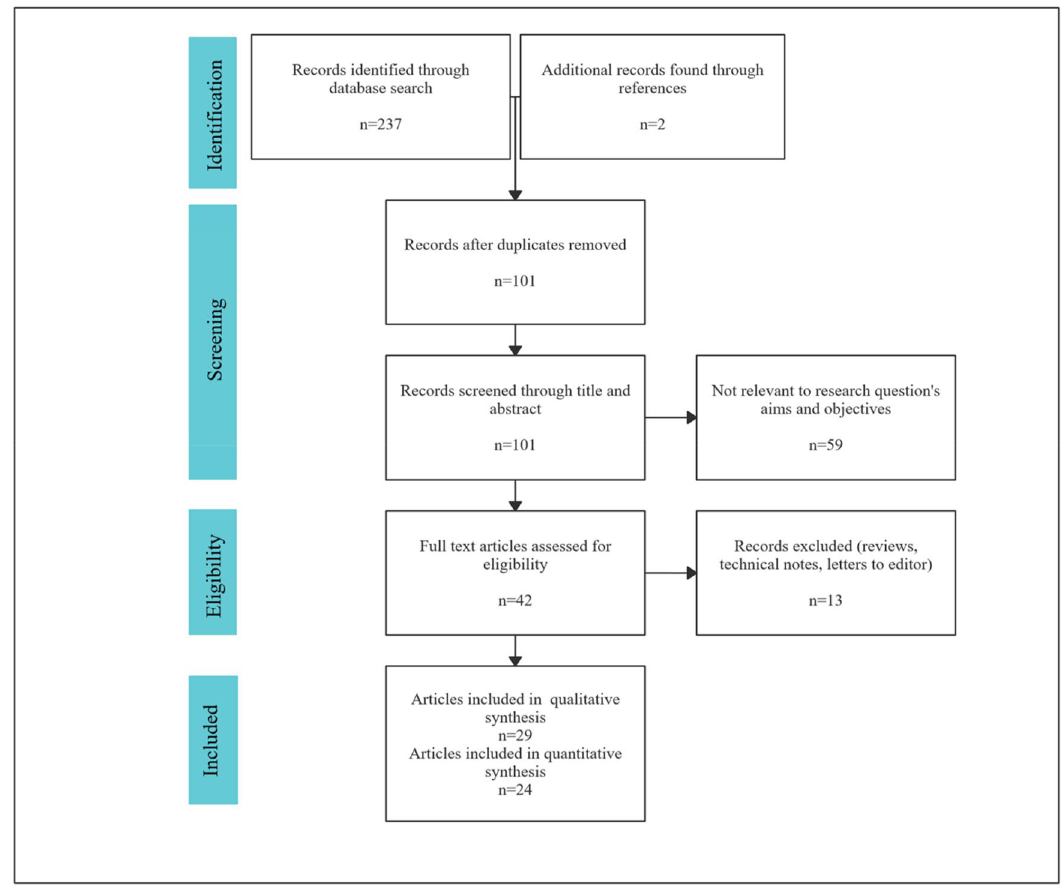
Figure 1. PRISMA flow